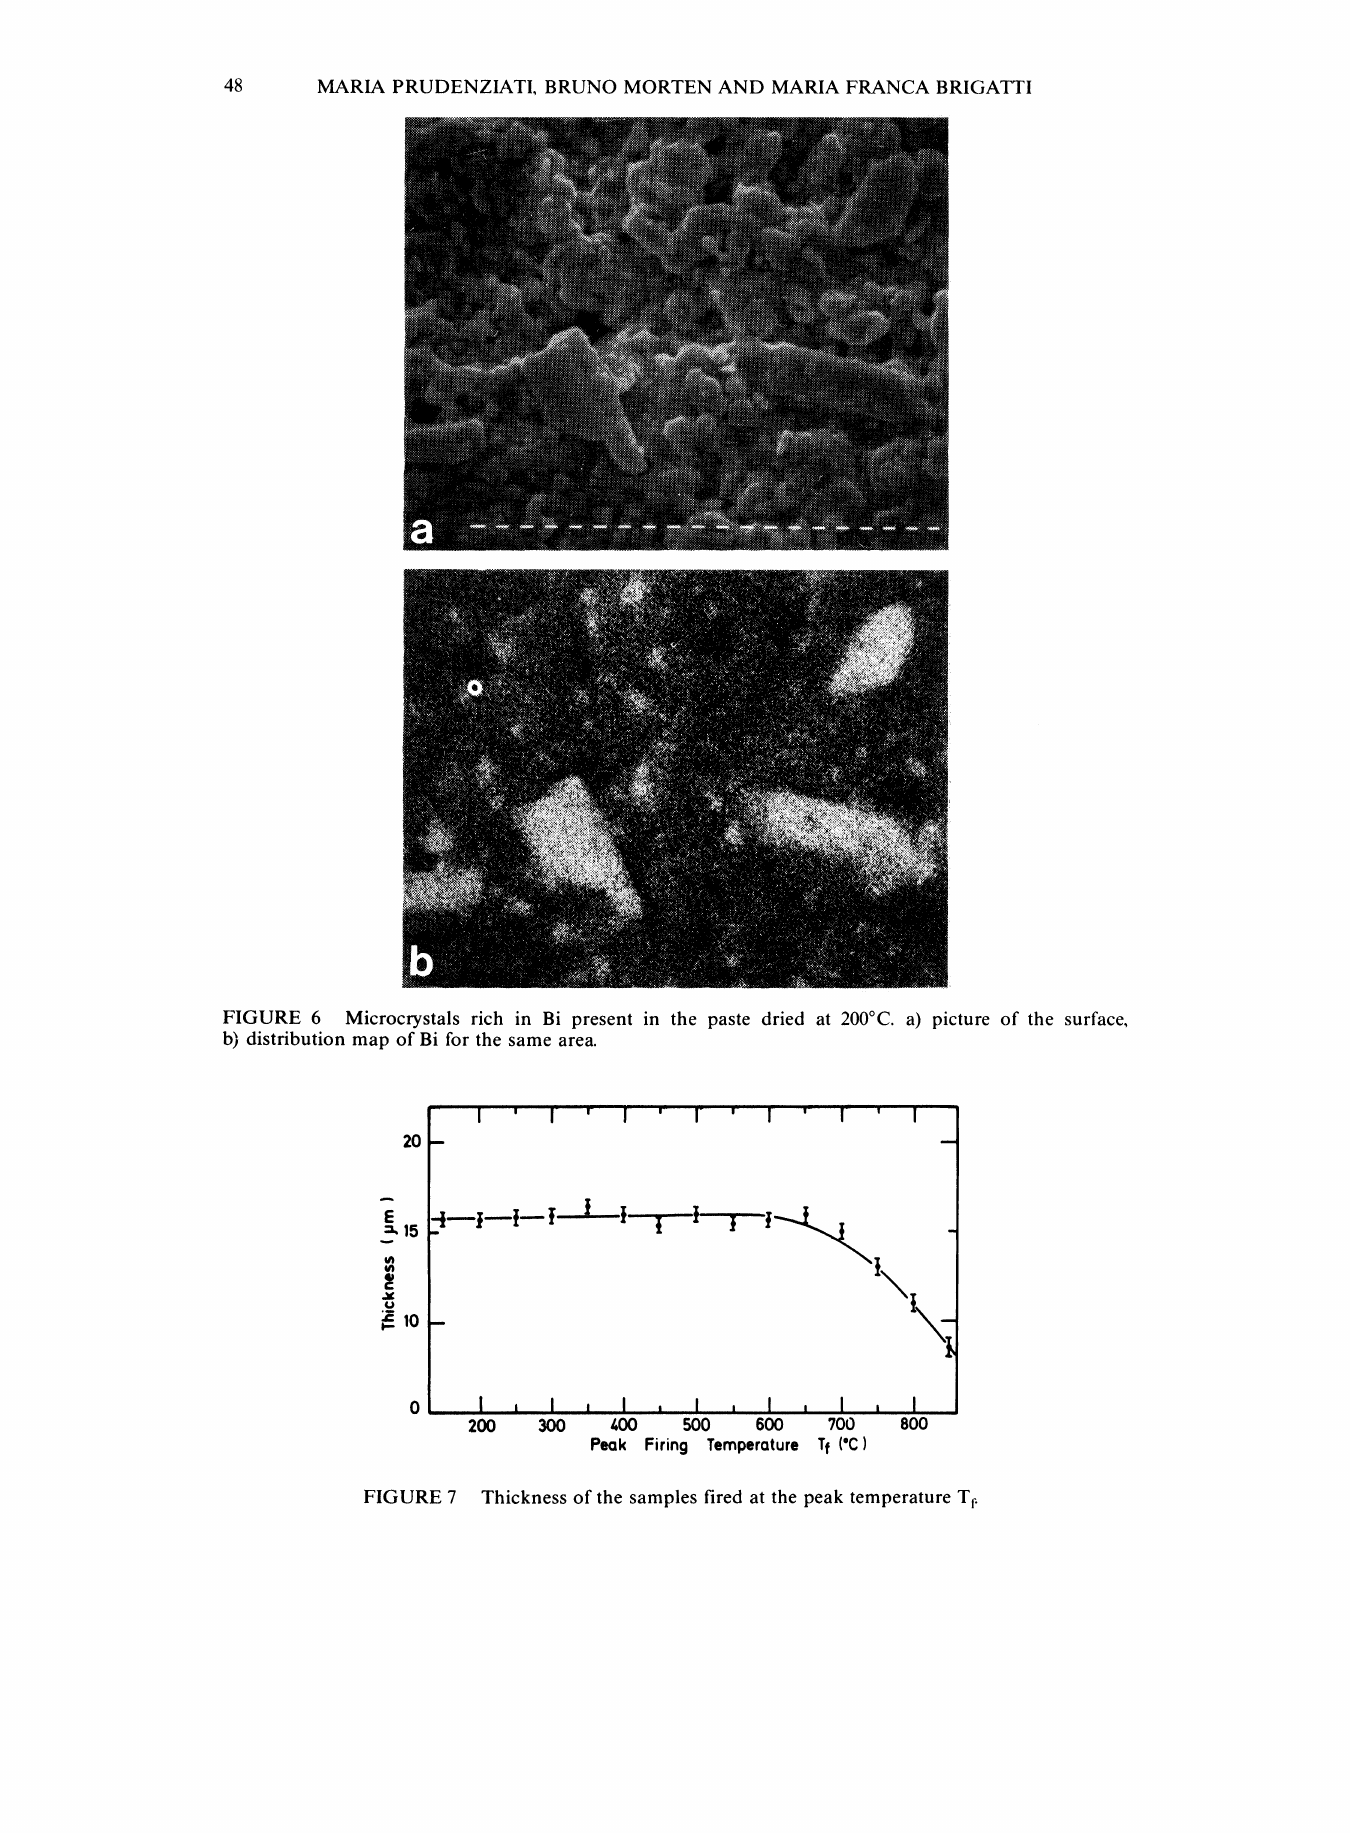
Thickness of the samples fired at the peak temperature